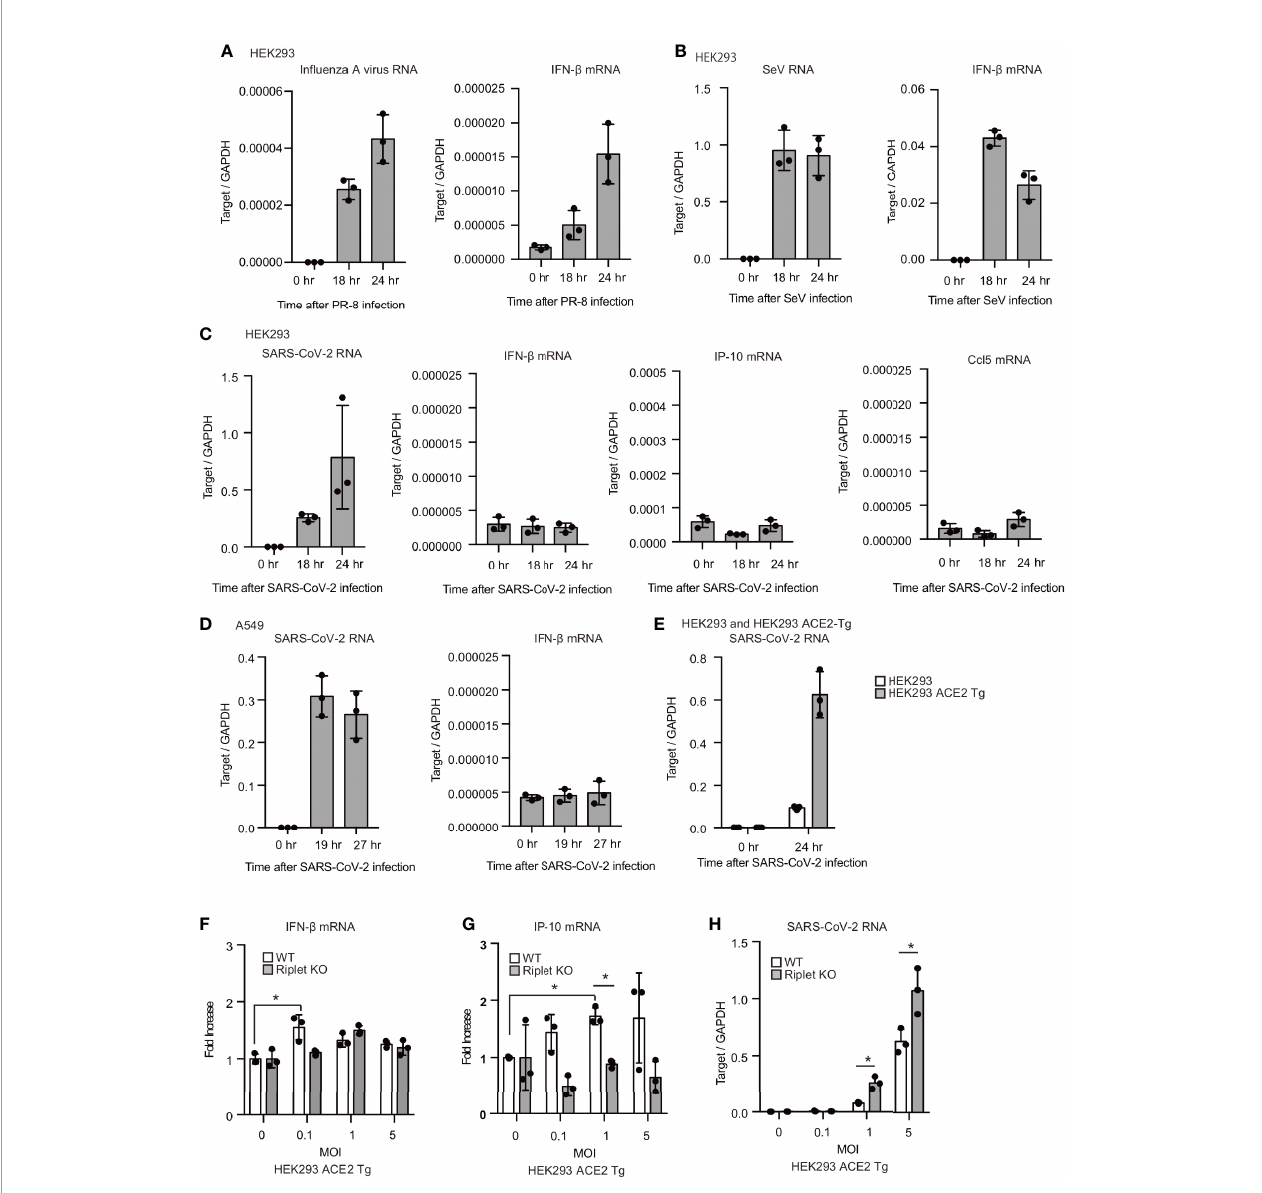
FIGURE 4 | SARS-CoV-2 hardly induced type I IFN expression in human cells. (A – C) HEK293 cells were infected with in fl uenza A virus, SeV, or SARS-CoV-2 at MOI = 1. Total RNA was extracted at the indicated time points, and RT-qPCR determined viral RNAs and IFN- b mRNA expression levels. The data represents the mean ± SD (n = 3). The data shown is representative of at least two independent experiments. (D, E) A549 (D) and human ACE2 overexpressing HEK293 cells (ACE2-Tg) (E) cells were infected with SARS-CoV-2 at MOI = 1. Total RNA was extracted at the indicated time points, and RT-qPCR determined viral RNAs and IFN- b mRNA expression levels. The data represent the mean ± SD (n = 3). The data shown is representative of at least two independent experiments. (F – H) WT and Riplet KO HEK293 ACE2 Tg cells were infected with SARS-CoV-2 at MOI = 0, 0.1, 1, and 5. Total RNA was extracted at 18 h after infection, and RT-qPCR determined IFN- b mRNA, IP-10 and SARS-CoV-RNA expression levels. The data are expressed as fold increase compared with expression level at 0 hr, and represent the mean ± SD (n = 3, *p < 0.05, t-test). The data shown is representative of at least two independent